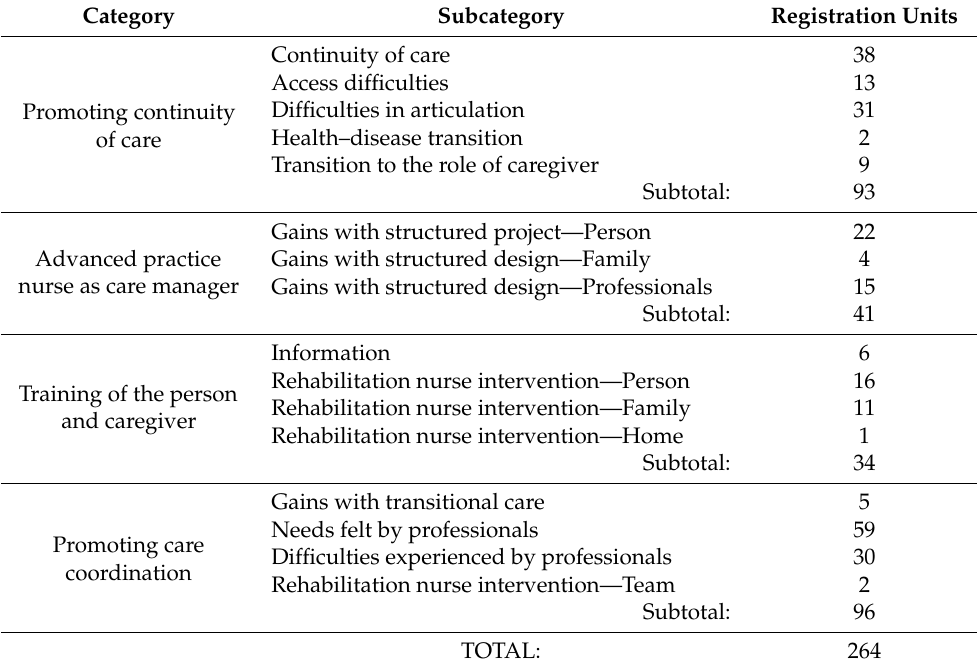
Table 1. Corpus of the content analysis from the focus group, Lisbon,